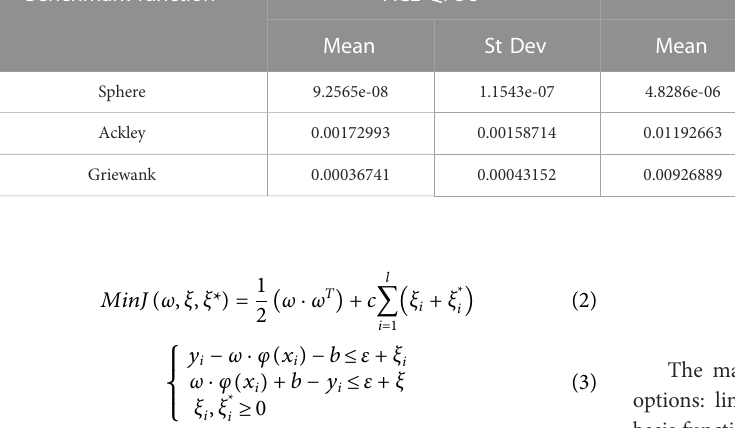
TABLE 2 Comparison of the results of each algorithm. Benchmark